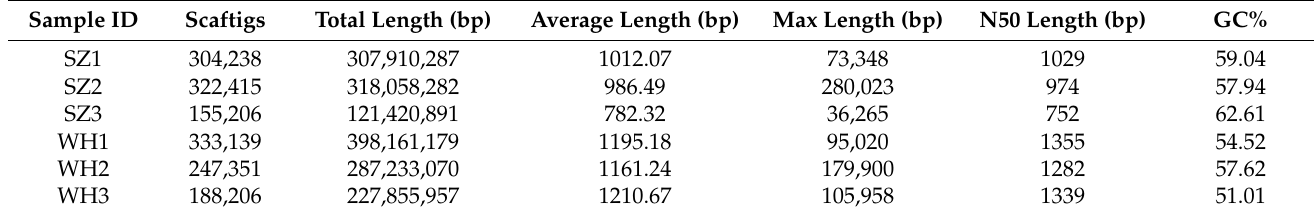
Table 1. Summary of the sequence data for six